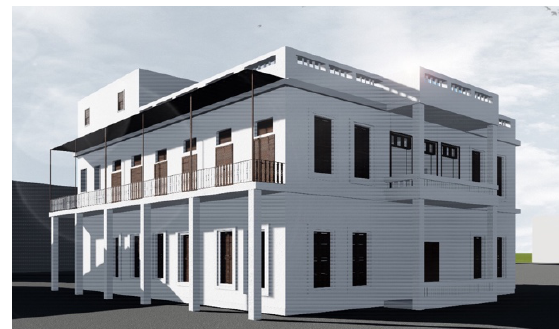
Figure 12: The 3D eBIM model of Bayt Zanal.